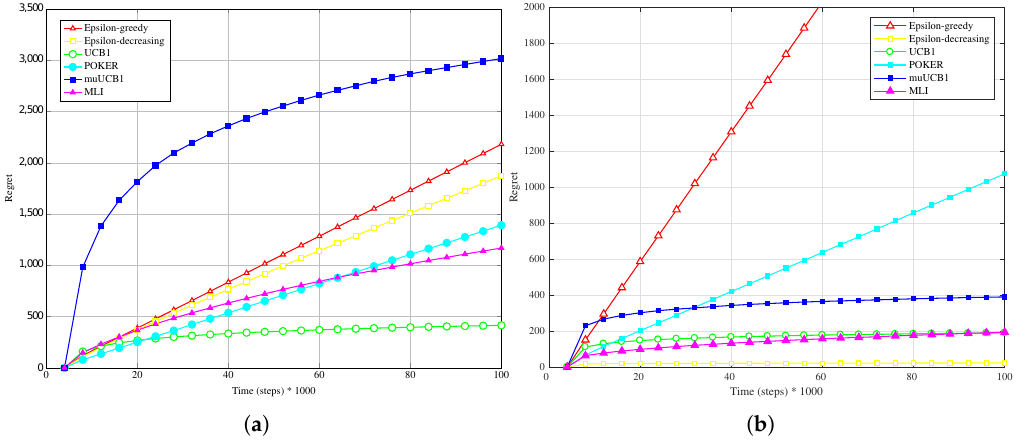
Figure 4. Performance in terms of regret of the six considered algorithms, with a truncated Gaussian distribution for the reward PDF and T U / T M = 1. ( a ) Hard configuration; ( b ) Easy configuration.